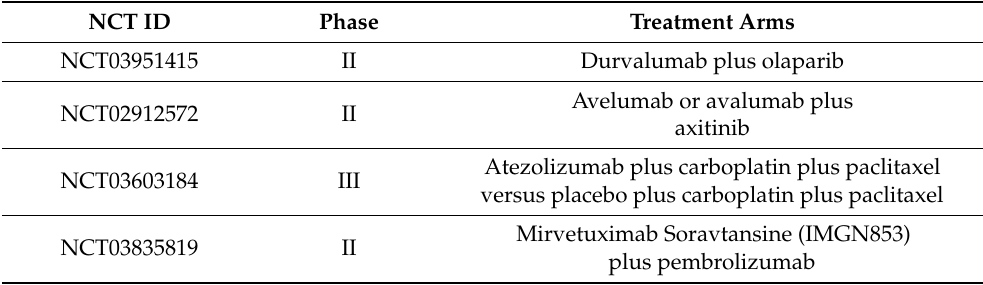
Table 1. Some ongoing clinical trials assessing immunotherapy in endometrial